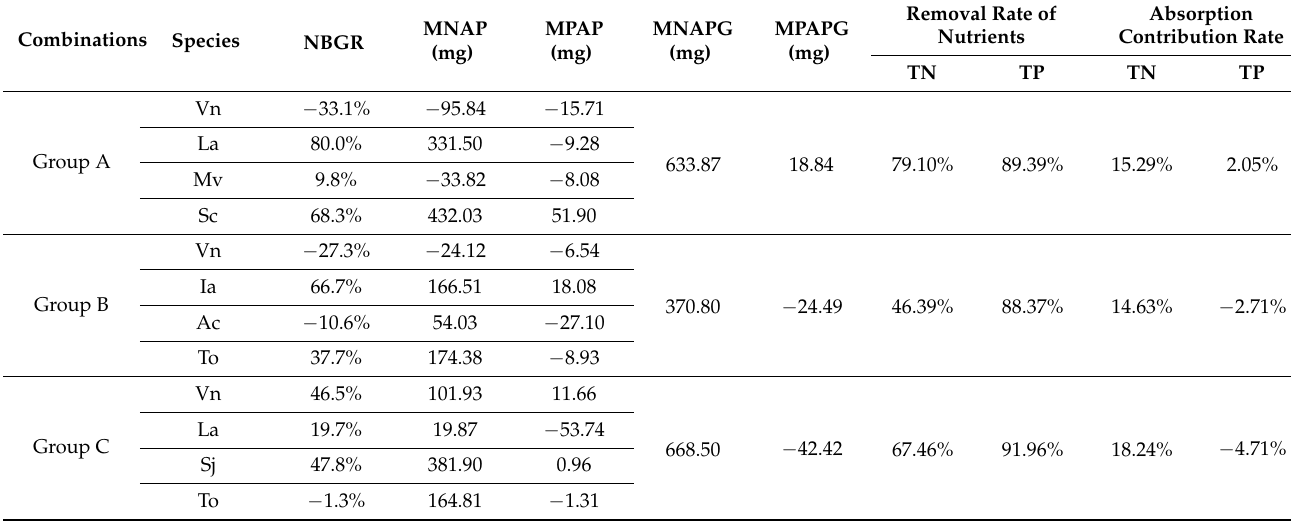
Table 3. The amount of nitrogen absorbed by plants and plant groups, the total removal rates of nutrients in water and absorption contribution rates of plants after 54 days’